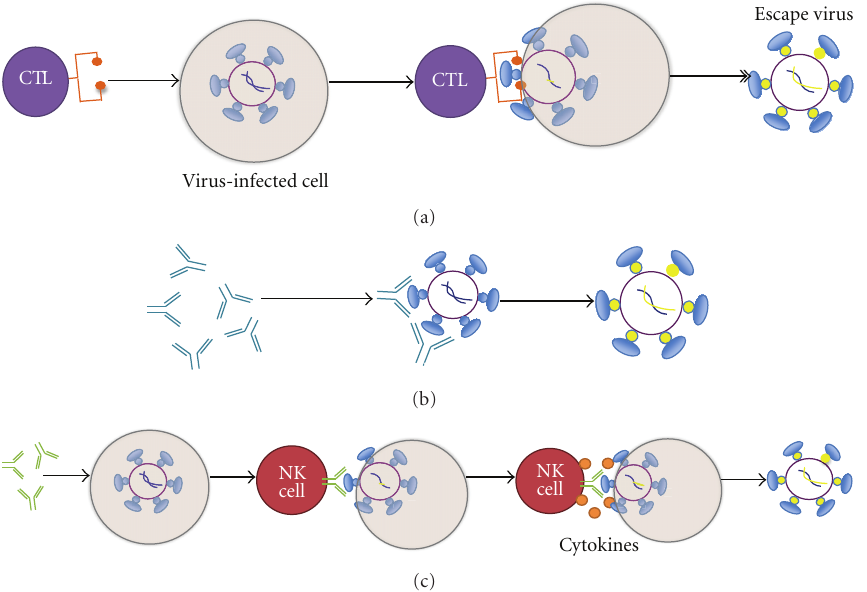
Figure 1: HIV-specific immune responses force immune escape. The mechanism of immune pressure applied by Cytotoxic T lymphocytes (a), neutralizing antibodies (b), and ADCC antibodies (1) is illustrated. Escape from immune responses shows results once free virus (Nab responses) or viral particles are presented either via the MHC class pathway (CTL responses) or possibly on the surface of the infected cell by virus budding